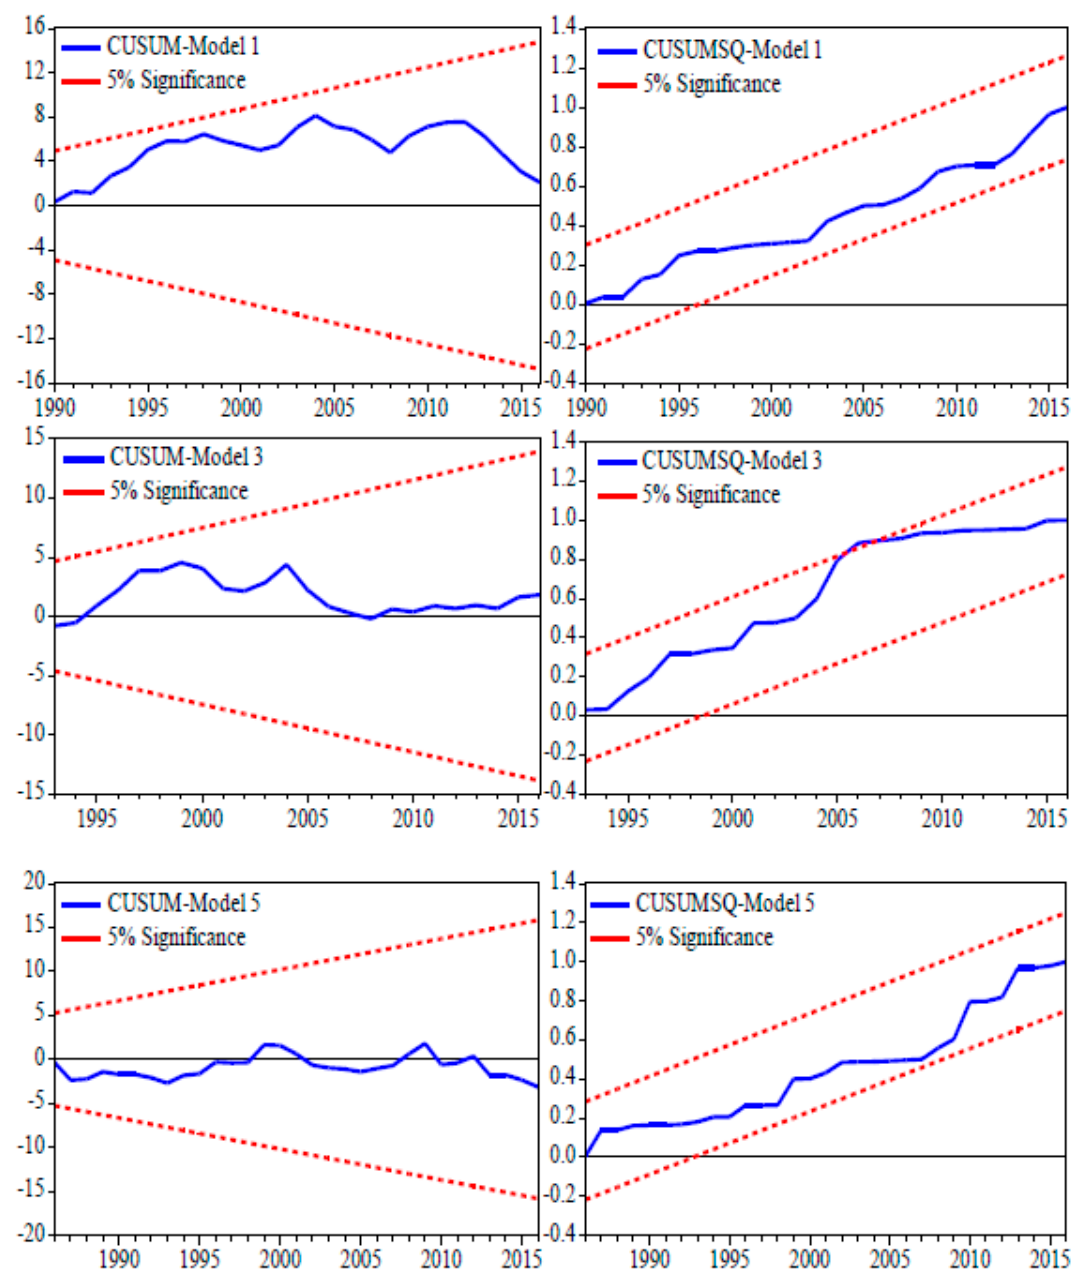
Figure A2. A. CUSUM and CUSUMSQ results.